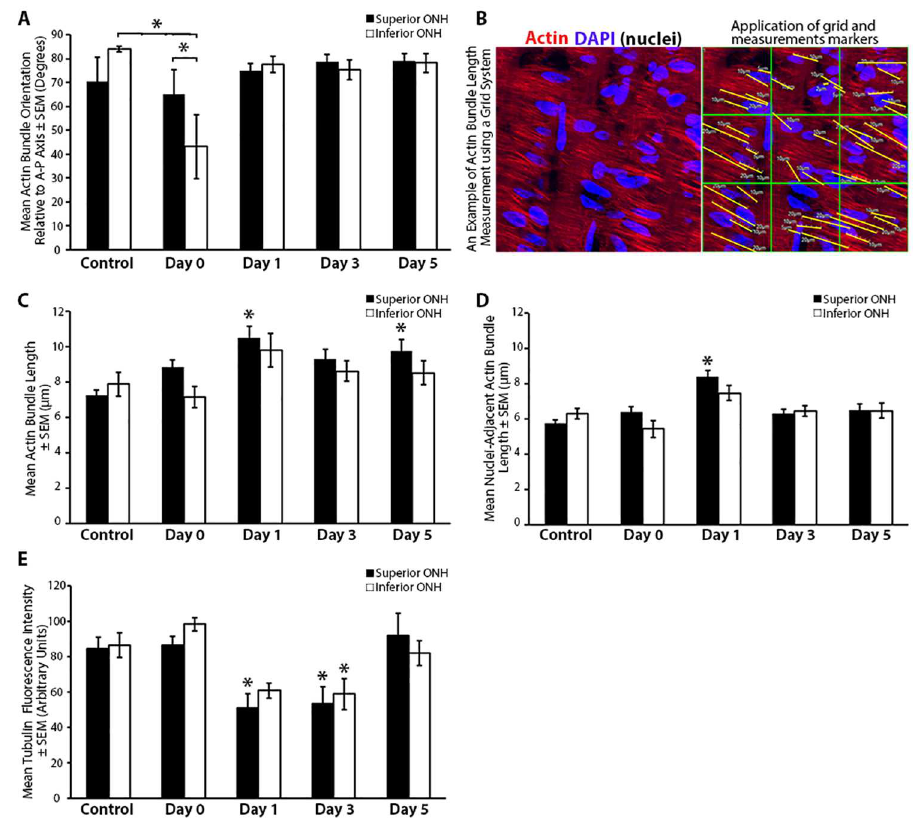
Fig 2. Quantitative analysis of actin-based astrocyteextension and axonal microtubule reorganization in response to elevated intraocular pressure. (A) Mean astrocytic actin bundleorientation relativeto the anterior-posterior axis within the superior and inferior optic nerve head (ONH) of control eyes and eyes exposedto 8 hours of intraocularpressure (IOP) elevation.(B) An exampleof the superior ONH with actin and nuclear co-labeling,before and after applicationof a grid to allowfor filament length measurement analysis. Note, in this example,only nuclear-adjacentactin bundles are identifiedand measured. (C) Mean length of actin bundles(with or without contact with a nucleus) within the superiorand inferior ONH of control eyes and eyes exposedto 8 hours of IOP elevation. (D) Mean length of actin bundlesin contact with a nucleus within the superiorand inferior ONH of control eyes and eyes exposedto 8 hours of IOP elevation. (E) Mean axonaltubulin fluorescence intensity within the superiorand inferior ONH of control eyes and eyes exposedto 8 hours of IOP elevation. Day 0 eyes were immediately fixed after 8 hours of IOP elevation,while day 1–5 indicatethe periodof time the IOP was normalizedpost IOP elevationprior to fixation. Error bars indicate standarderror of the mean (SEM); * = p < 0.05by 2-way ANOVA and indicatesstatistically significant difference betweencontrol and experimental groups; n = 7, 7, 7, 8, and 6 for control, day 0, day 1, day 3, and day 5 groups, respectively. A-P =